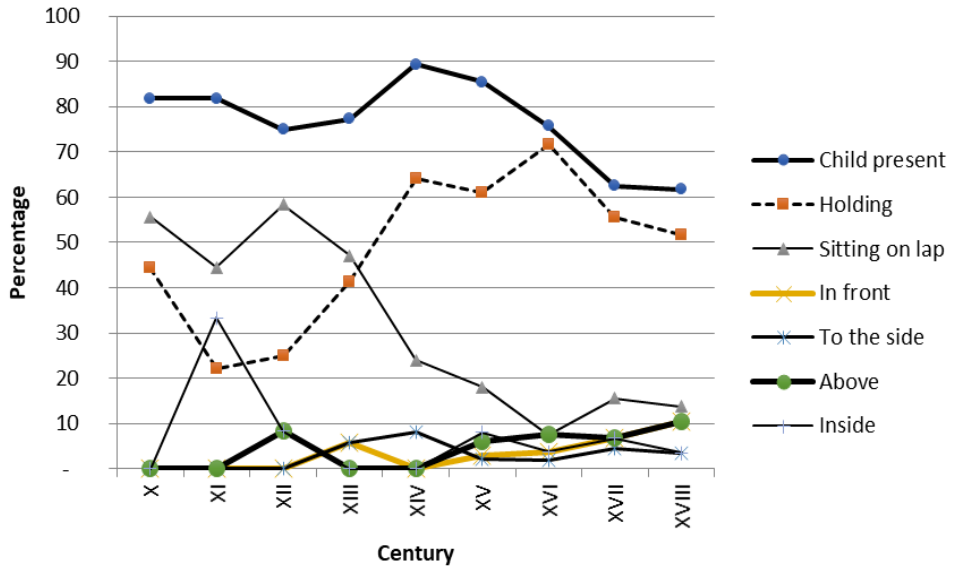
Figure 7. The Christ Child’s position with respect to Mary (Spain, tenth to eighteenth centuries). Source: Authors’ elaboration based on Trens (1946).